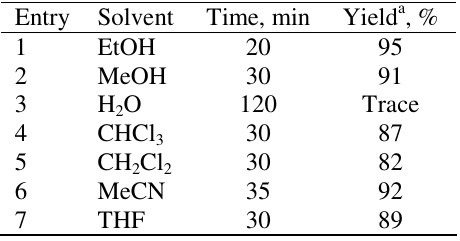
Table 2. The effect of different solvents on the reaction of benzene-1,2-diamine with benzil in the presence of bentonite clay K-10 at room temperature.